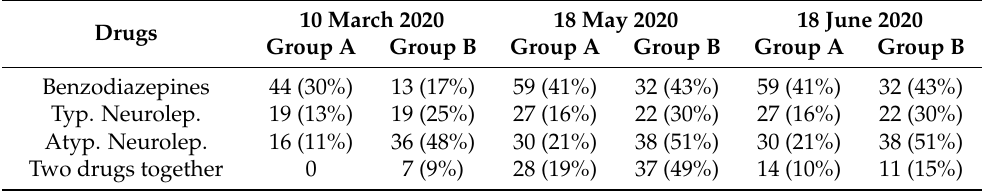
Table 8. Drugs variants during lock-down (reported patients prescribed and their %).